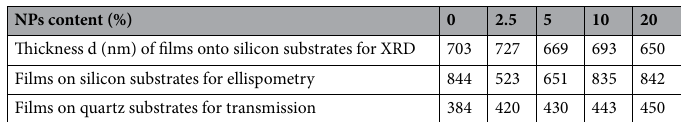
Table 3. Thickness of films, deposited on different